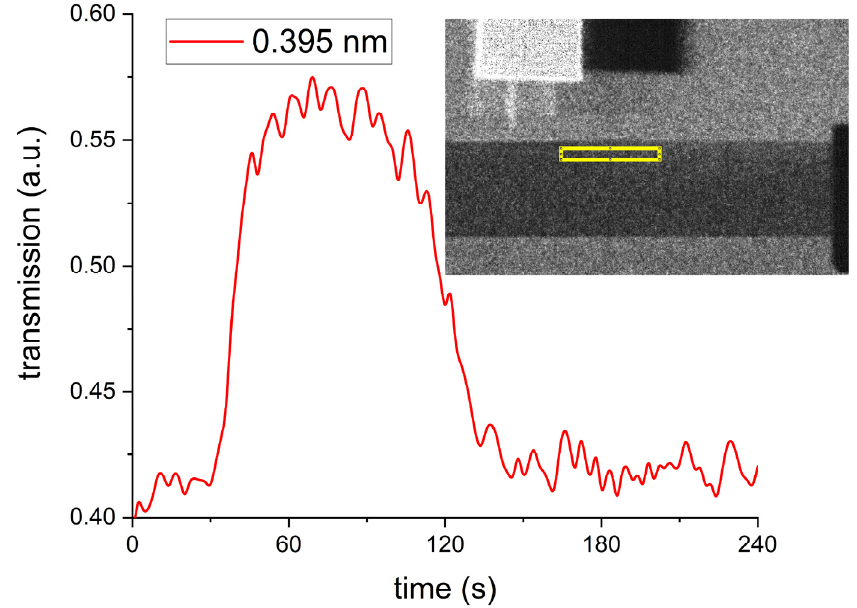
Figure 3. Plot of the transmitted intensity at λ = 0.395 nm measured as mean value from the ROI (yellow rectangle) as a function of time. The insert shows the monochromatic image taken at t ≈ 130 s. The very low neutron intensity results in a poor image quality, showing essentially no visual image contrast in the sample for all times.